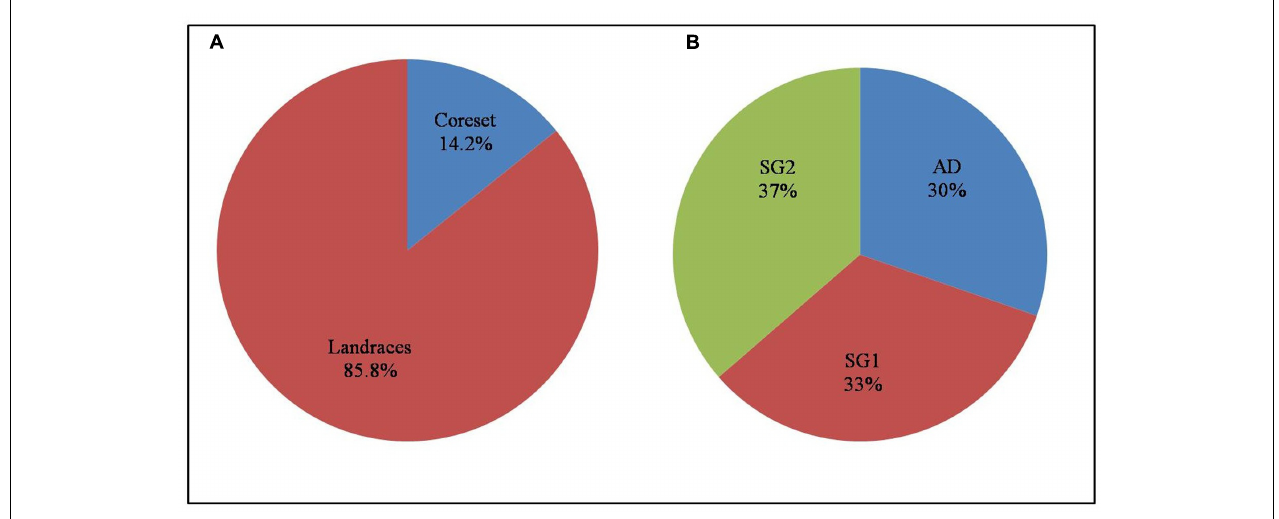
FIGURE 6 | Depiction of (A) core set land races and (B) distribution of its subgroups.